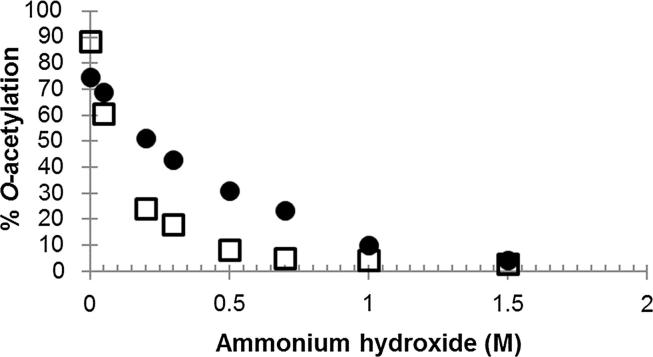
Effect of ammonium hydroxide treatment on the O-acetylation level of Vi polysaccharide standards from C. fruendii and S. Typhi. The points from control and de-O-acetylated Vi standard from C. freundii (●) and S. Typhi (□) are the means of values determined in two to four independent assays. Confidence intervals are included on untreated and 1.0 M base-treated. Base treatment was performed at 37 °C for 18 h, and O-acetylation was determined by the Hestrin method.